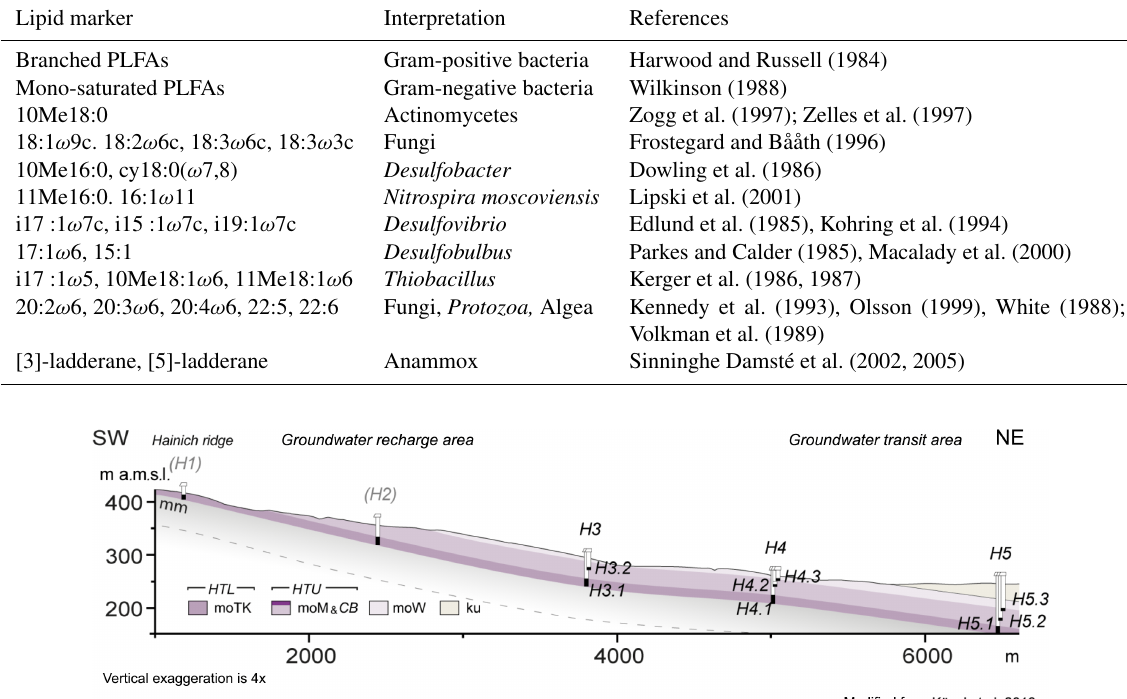
Table 1. Lipid markers proposed to represent a group or genus of microorganisms. Lipid marker